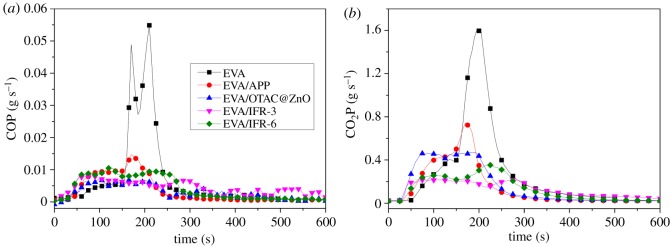
COP (a) and CO2P (b) curves of pure EVA and EVA composites.